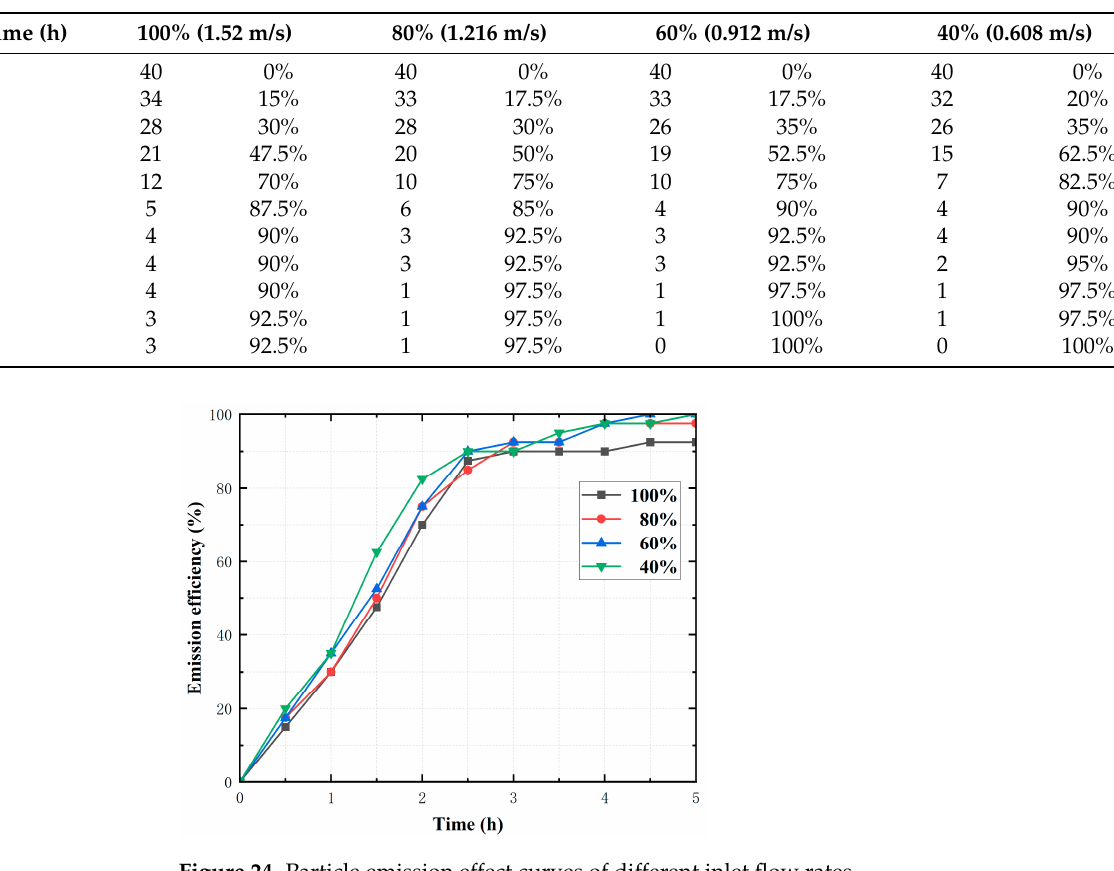
Table 3. Statistics of emission results at different flow rates under optimal conditions.